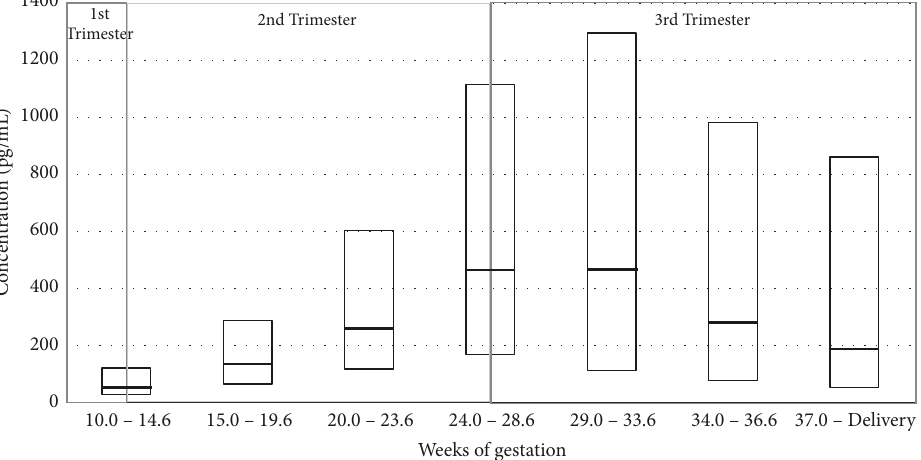
Figure 3: PlGF levels (pg/mL) measured in normotensive women during different weeks of gestation (based on data from Roche Study no. CIM